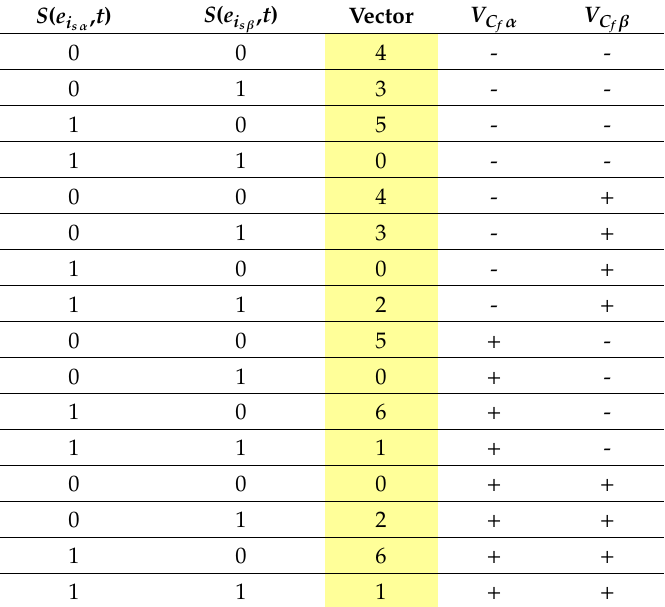
Table 1. Choice of the current vector function of the sliding surfaces and capacitors voltages